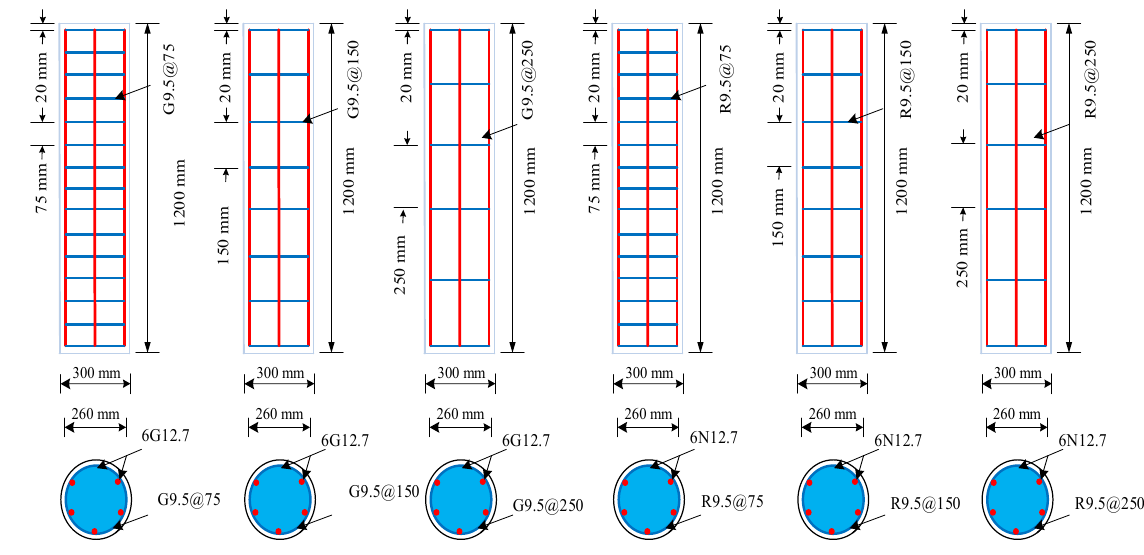
Figure 2. Geometrical parameters of manufactured specimens. Table 4. Test matrix.